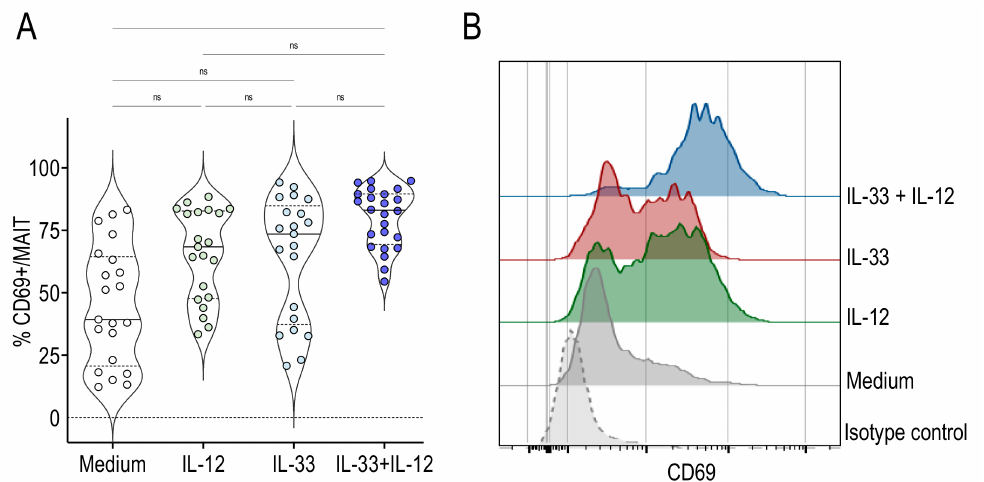
Figure 1. IL-33 + IL-12 activated human MAIT cells. ( A ) Percentages of CD69+ cells among gated MAIT cells stimulated for 48 h with IL-12, IL-33 or IL-33 + IL-12. Bars indicate medians and quartiles. Data were acquired from six donors in four experiments. ( B ) Histograms on the right are representative of CD69 expression among gated MAIT